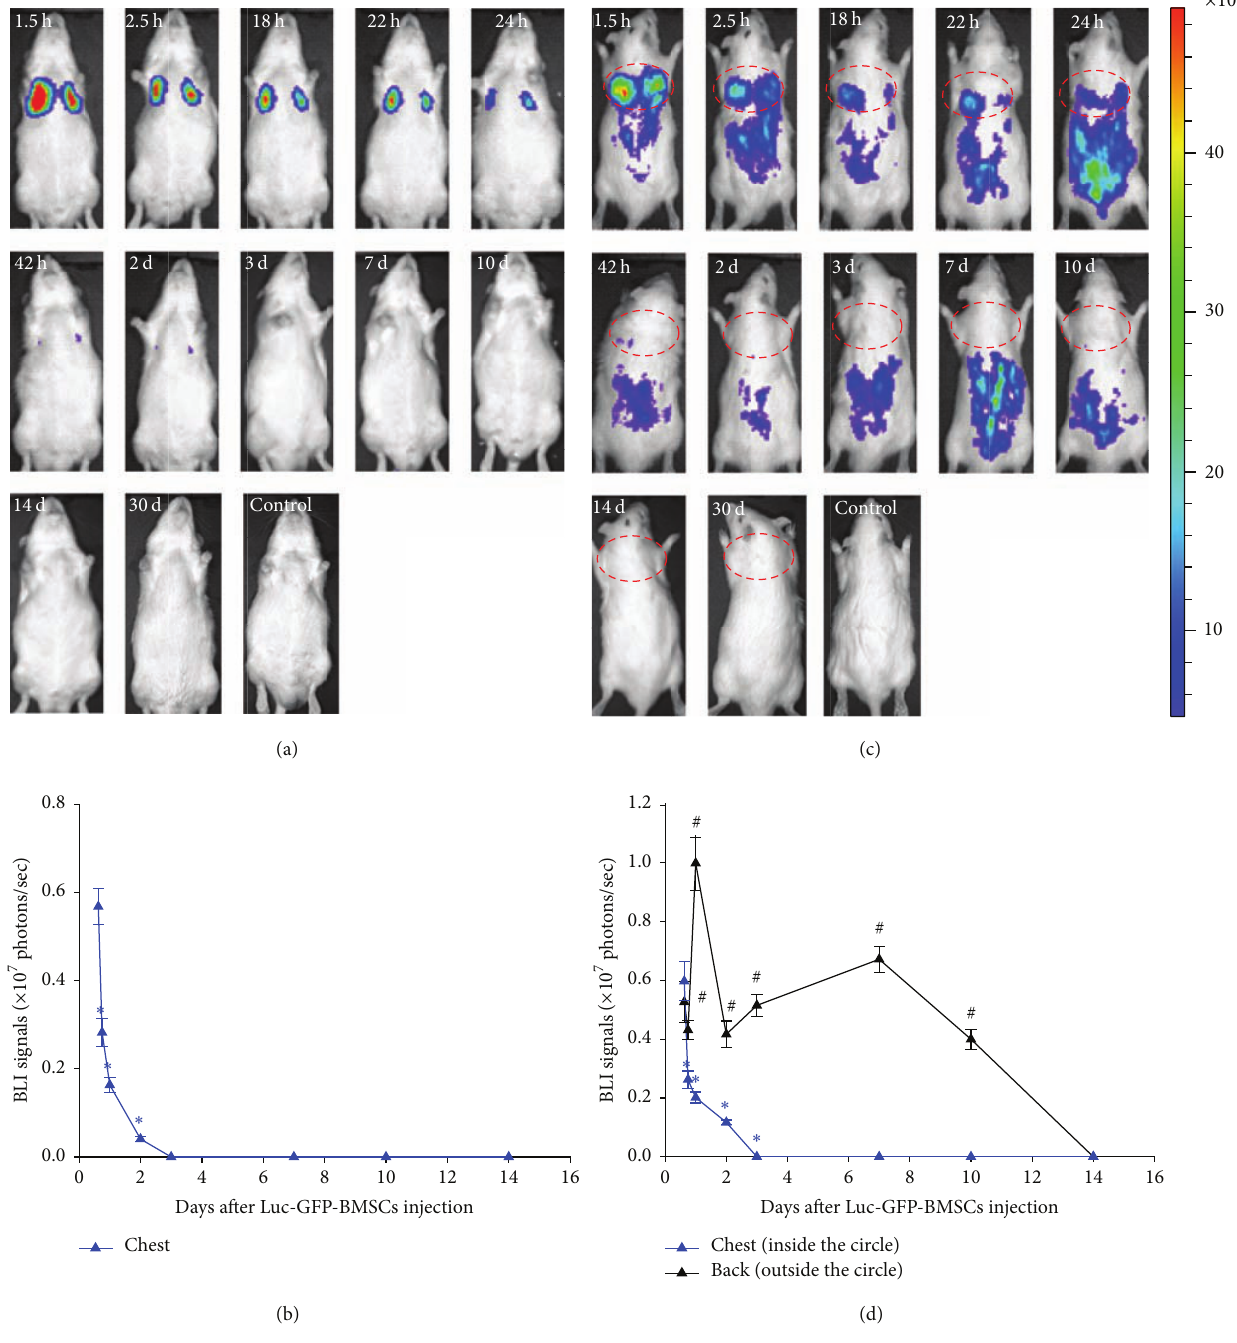
Figure 2: BLI of the transplanted Luc-GFP-BMSCs in vivo . (a and c) Luc-GFP-BMSCs suspended in PBS were injected into normal rats, while PBS alone was injected as a control. Cells were imaged at different time points, showing initial detention in the lungs and gradual concentration in the back, demonstrating that BMSCs may possess a tissue-specific binding capacity for some organs. However, the signals disappeared at day 14, revealing the final loss of transplanted BMSCs in normal rats. (b and d) Quantitative analysis of BLI signals in the chest and back. Bioluminescence activity steadily decreased over time in the chest. However, in the back, significant enhancement occurred at one and seven days after injection. ∗ 𝑃 < 0.05 versus BLI signals in the chest at 1.5h ( 𝑛 = 5 ); # 𝑃 < 0.05 versus BLI signals in the back at 1.5 h ( 𝑛 = 5